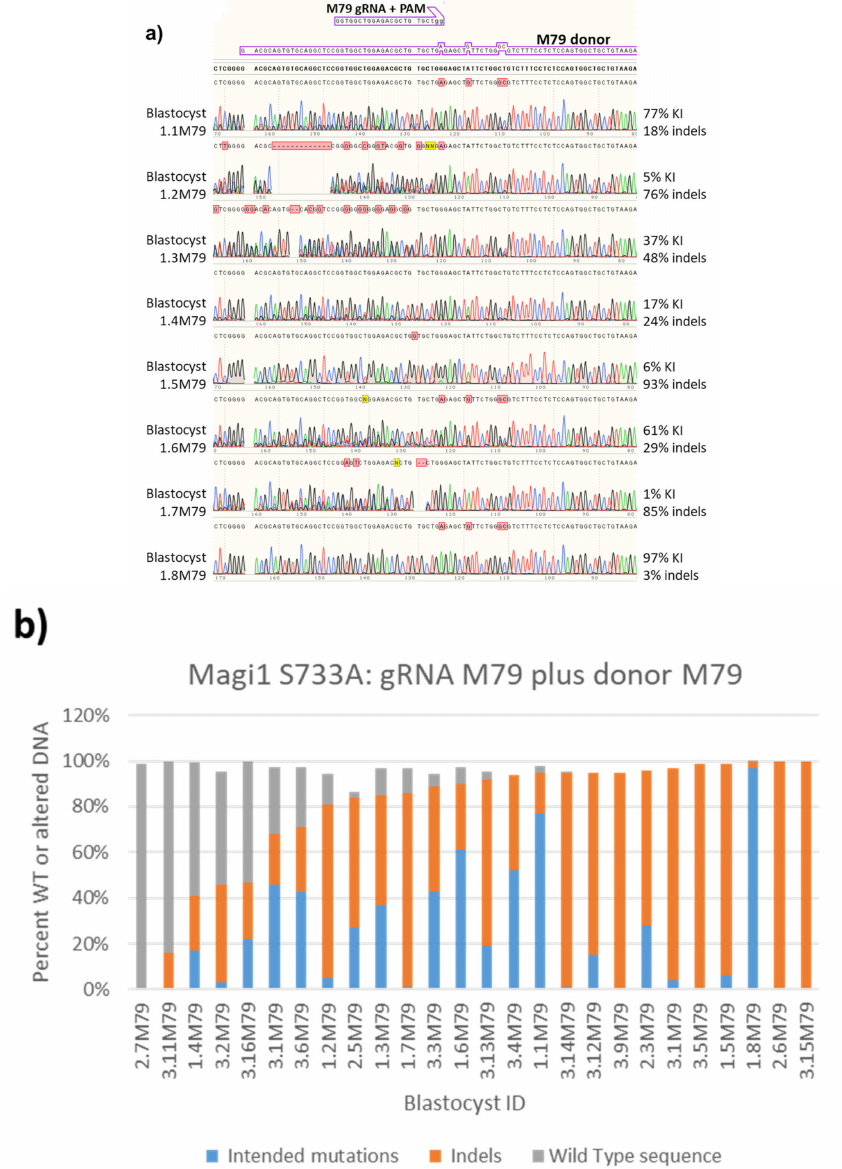
Figure 4. Silent mutations in the PAM region prevent recutting. The percentages of desired knock-in (KI) point mutations and indels in each blastocyst were quantified from their Sanger sequences using Synthego’s ICE program (https: // ice.synthego.com / # / ). ( a ) The chromatograms generated using the primer upstream of the S733A mutations, for 8 blastocysts injected with guide RNA gR8179 (M79), and the percent KI mutations and indels of each are quantified. The chromatogram as read from right to left of the blastocyst 1.1M79 from Figure 3 is in the top position. The sequence for each blastocyst is shown above its chromatogram. The WT sequence is shown in bold at the very top. ( b ) Bar graph of the percent KI mutations, indels and WT sequence quantified for each blastocyst from three separate experiments with guide M79. Each bar shows the quantified percent WT, indels and desired point mutations for a single blastocyst. The three experiments were combined and bars organized from blastocysts containing the least percent of cut genomic DNA to the most cut. Results from each experiment appear repeatable as data from each experiment show roughly the same pattern of percent indels and donor sequence integration. In addition, the fraction of DNA containing indels plus KI mutations does not exceed 100%. Once the altered PAM sequence is incorporated into the genomic DNA, the silent PAM point mutation appears to prevent additional editing by Cas9 and therefore prevent indels from forming in the same